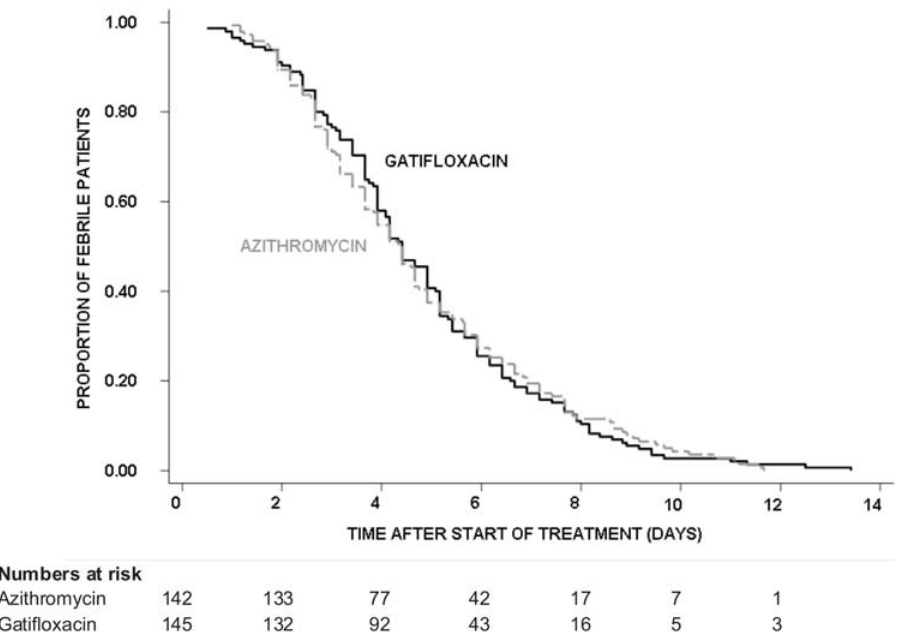
Figure 2. Proportion of culture confirmed patients still febrile. Kaplan-Meier survival curve showing the proportion of culture confirmed patients (PP analysis) still febrile through time by treatment group.